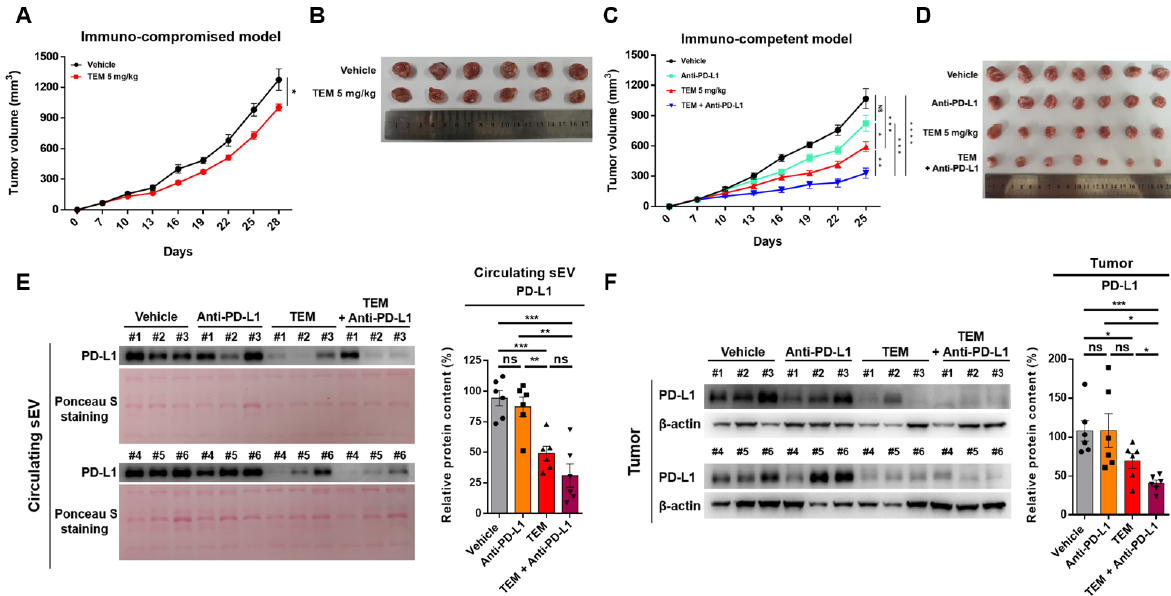
Figure 4. Temsirolimus (TEM) augments anti-cancer effects by inhibiting sEV PD-L1 and cellular PD-L1 levels in the 4T1 tumor model. ( A – D ) The growth curves ( left ) and tumor image ( right ) of 4T1 breast cancer in ( A , B ) immunocompetent mice and ( C , D ) nude mice ( n = 6–7). ( E ) The immunoblots of PD-L1 of the circulating sEV and ( F ) cellular PD-L1 levels in tumors treated with or without TEM ( left ). The quantitative analysis of the relative protein expression ( right ). The data are presented as means ± standard error of the mean (SEM). * p < 0.05, ** p < 0.01, *** p < 0.001, and **** p < 0.0001, respectively; ns, not significant.